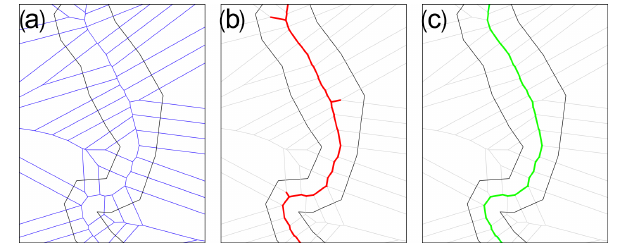
Figure 3. The filtering of the centerline segments, (a) original Voronoi segments, (b) Voronoi segments filtered for segments that lie fully within the channel polygon, and (c) filtered for dead